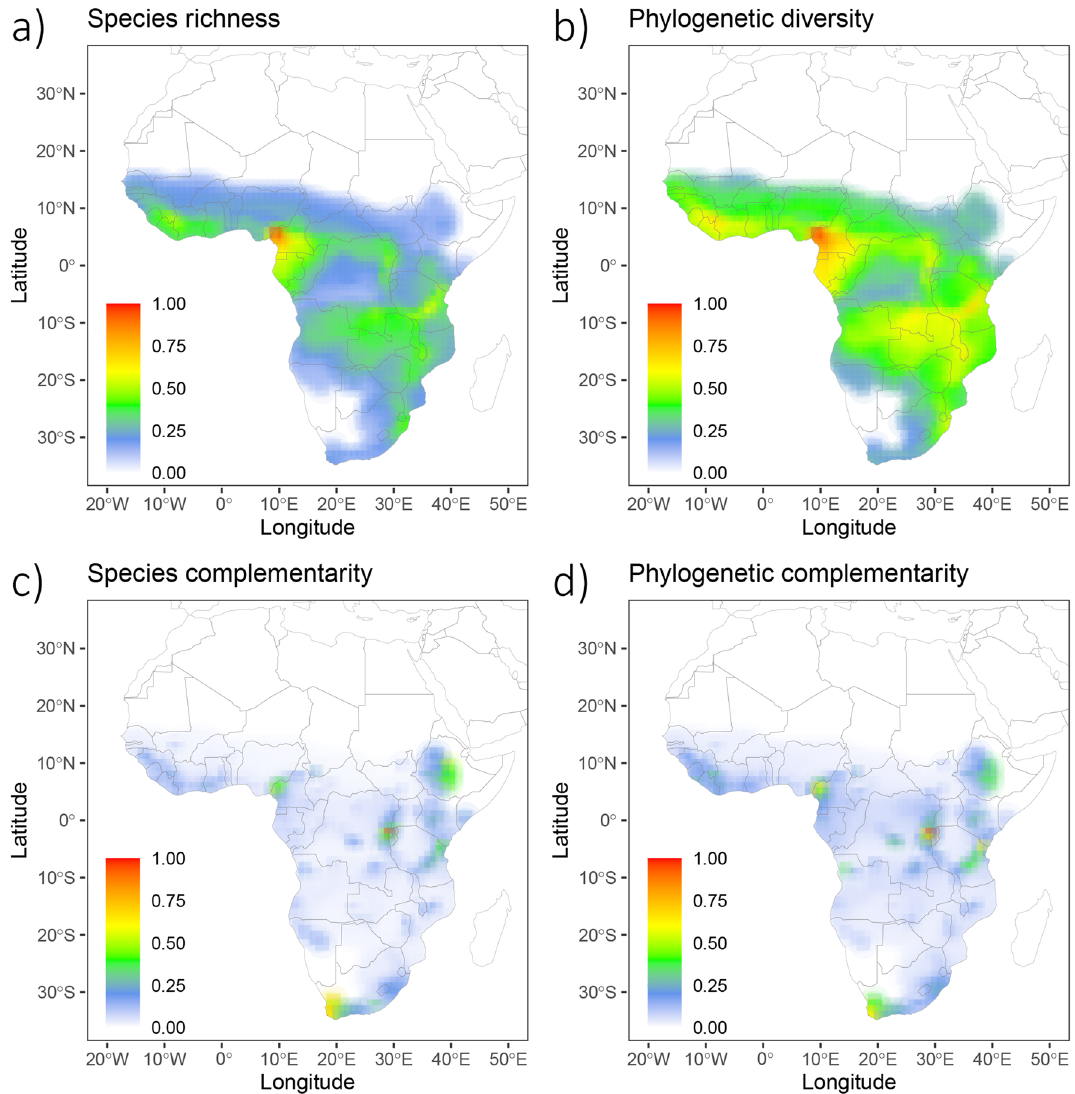
Figure 3. Taxonomic (species richness) and phylogenetic diversity and complementarity of amphibian species across sub-Saharan Africa at 1° resolution. All values are scaled relative to the highest observed value. ( a ) Species richness and ( b ) phylogenetic diversity (Faith’s PD) are measured as the number of frog species whose ranges overlap in a grid cell and their combined branch lengths in the frog phylogeny, respectively. Species richness and phylogenetic diversity peak in western Central Africa. ( c ) Species complementarity and ( d ) phylogenetic complementarity describe the contribution of each grid cell to overall species richness and phylogenetic diversity, respectively, relative to the number of the diversity found in the grid cell. Grid cells that include a high percentage of species/phylogenetic lineages that are shared with few other grid cells show high complementarity; grid cells with a high percentage of species/phylogenetic lineages that occur in many other grid cells show low complementarity. Species and phylogenetic complementarity peak in the Albertine Rift (including Rwanda), East Africa, and the Cape Region. Figure created with R 4.1 78